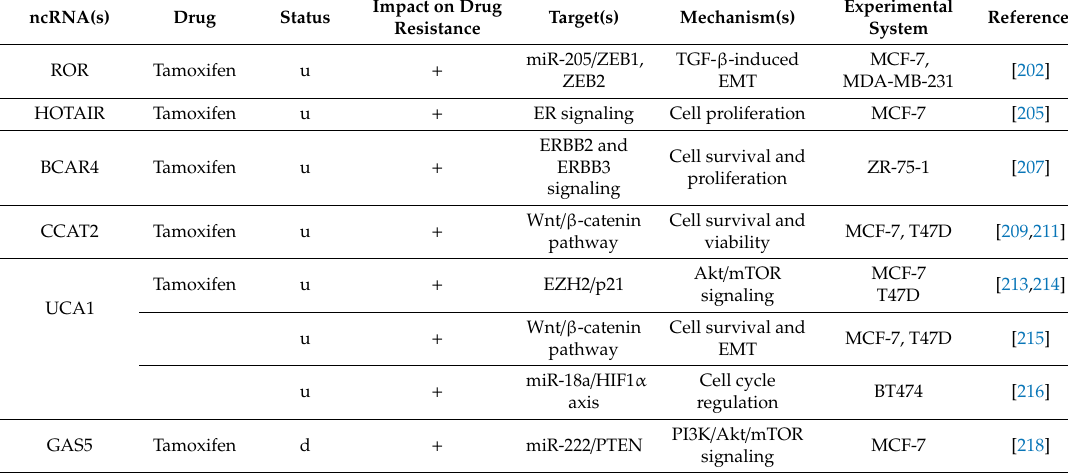
Table 4. Oncogenic and tumor suppressor lncRNAs associated with BC endocrine resistance 1 ; (u) upregulated; (d) downregulated; ( + ) increase; ( − )